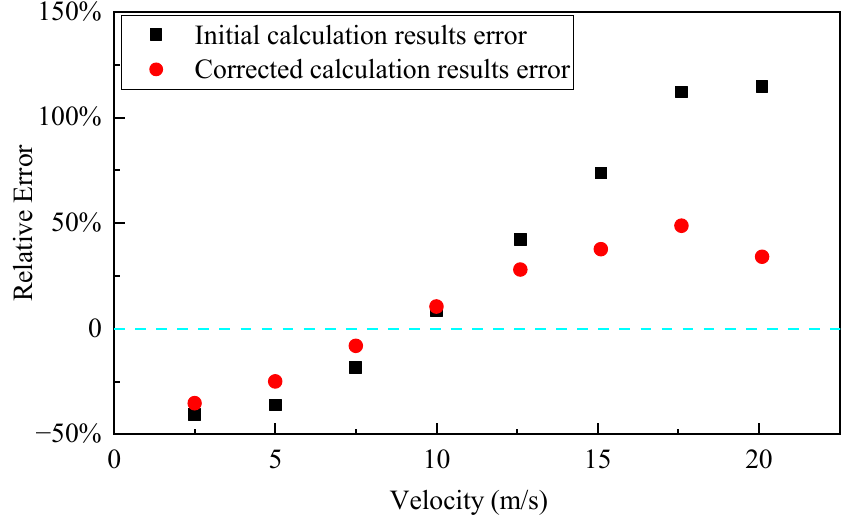
Figure 9. Relative error between the experimental results, and the initial calculation results and corrected calculation results.